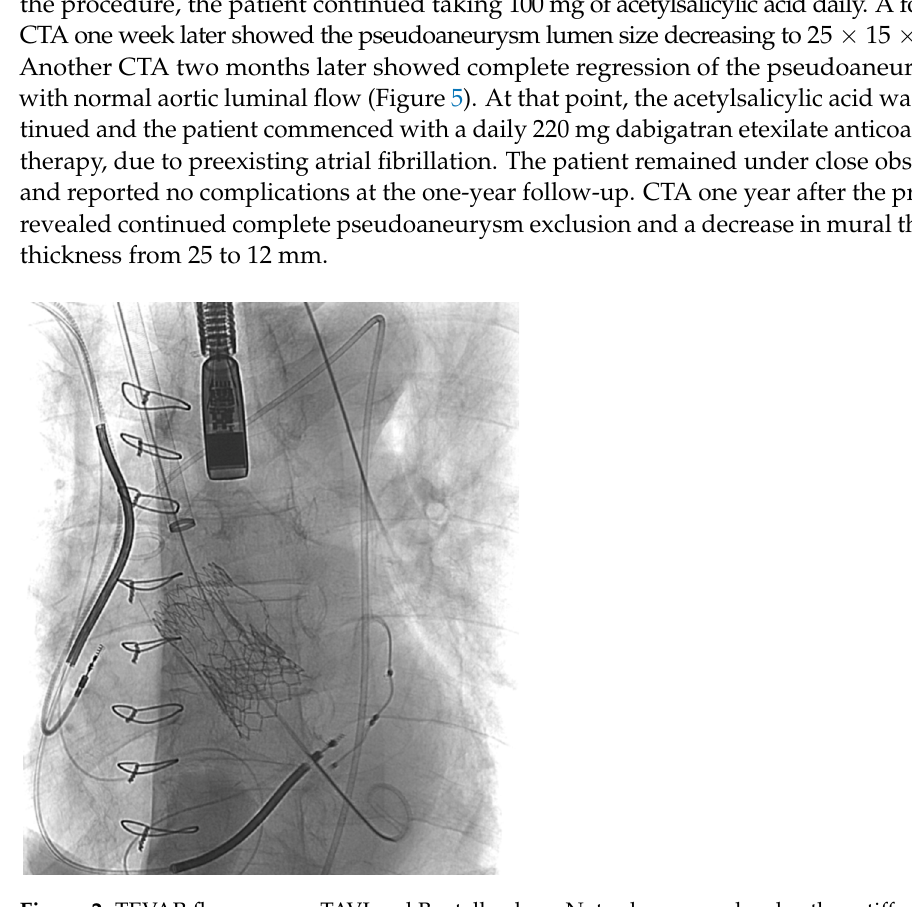
Figure 2. TEVAR fluoroscopy: TAVI and Bentall valves. Note also a vascular sheath, a stiff guidewire, and a TEE